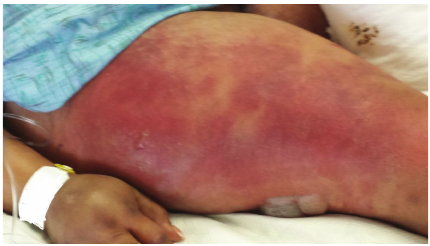
Figure 1: Erythematous rash with nonblanching edema, bleb formation, skin peeling, and areas of bogginess at the lateral aspect of right thigh.